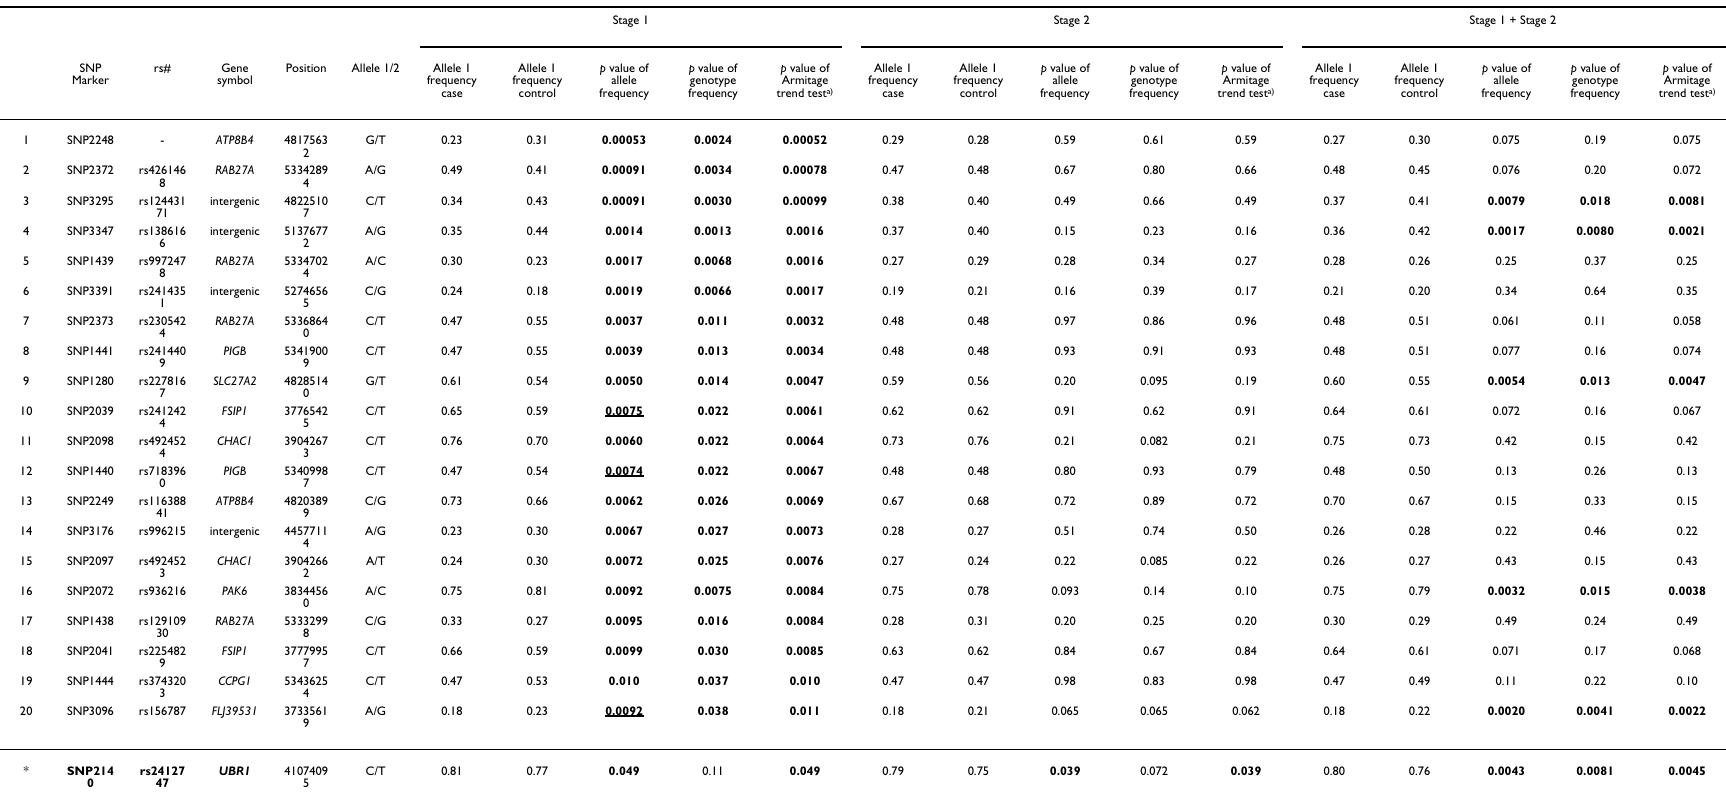
Table 3: Top 20 SNPs and the landmark SNP2140 in Stage 1 allelic and genotypic association